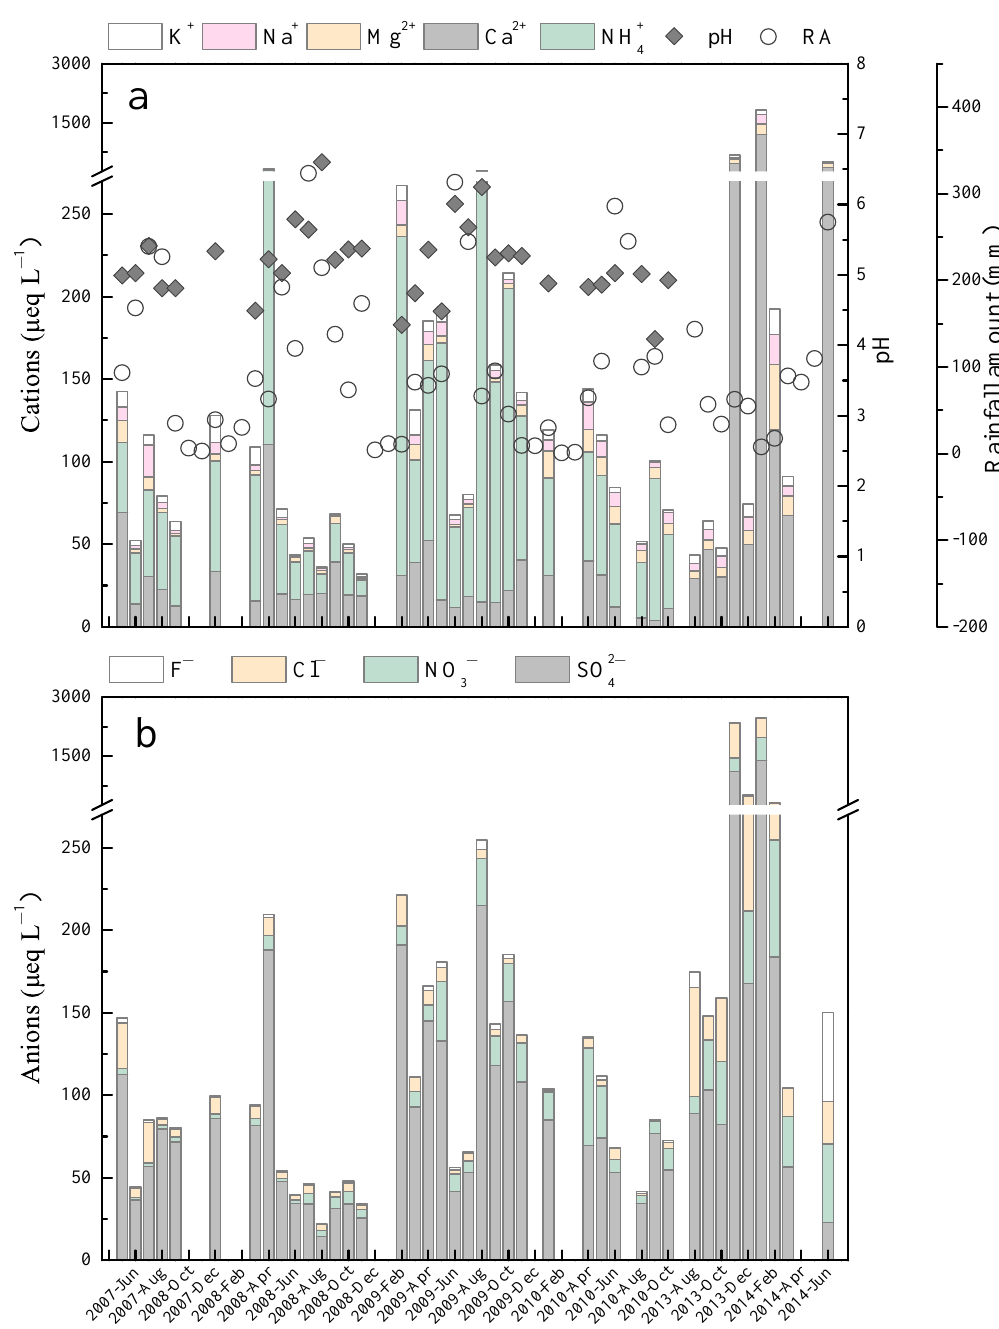
Figure 5. Monthly variations of ( a ) cation concentrations, rainfall amount (RA), and pH. ( b ) Anion concentration in the